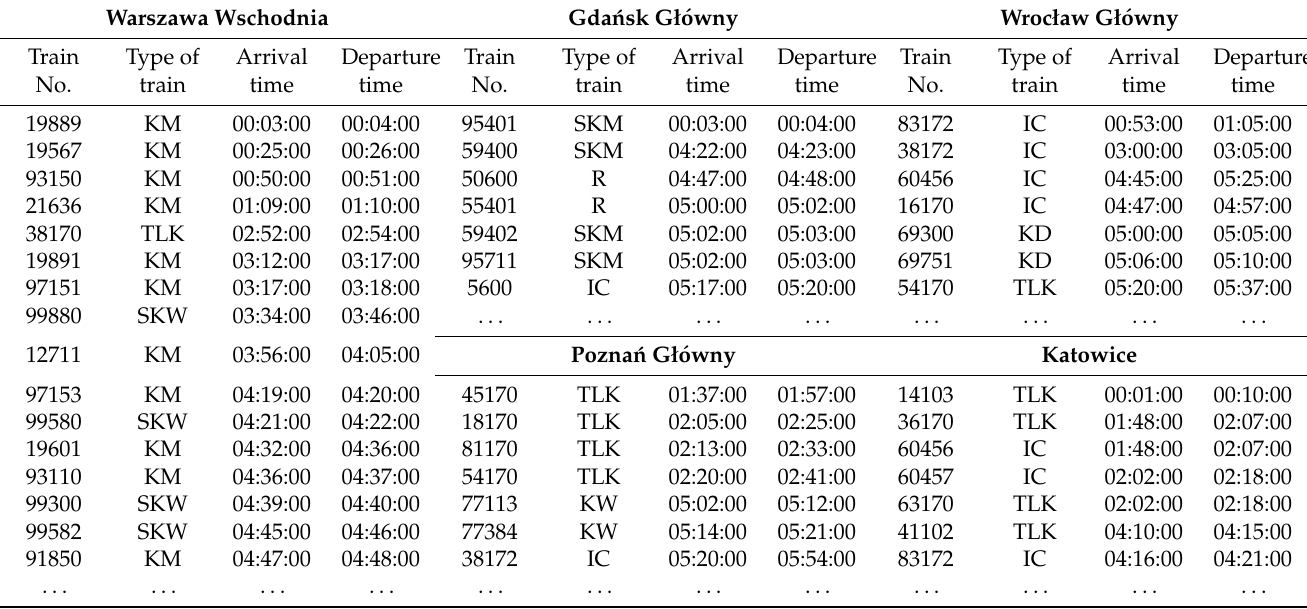
Table 1. Extract from the train timetable in selected railway stations in Poland.